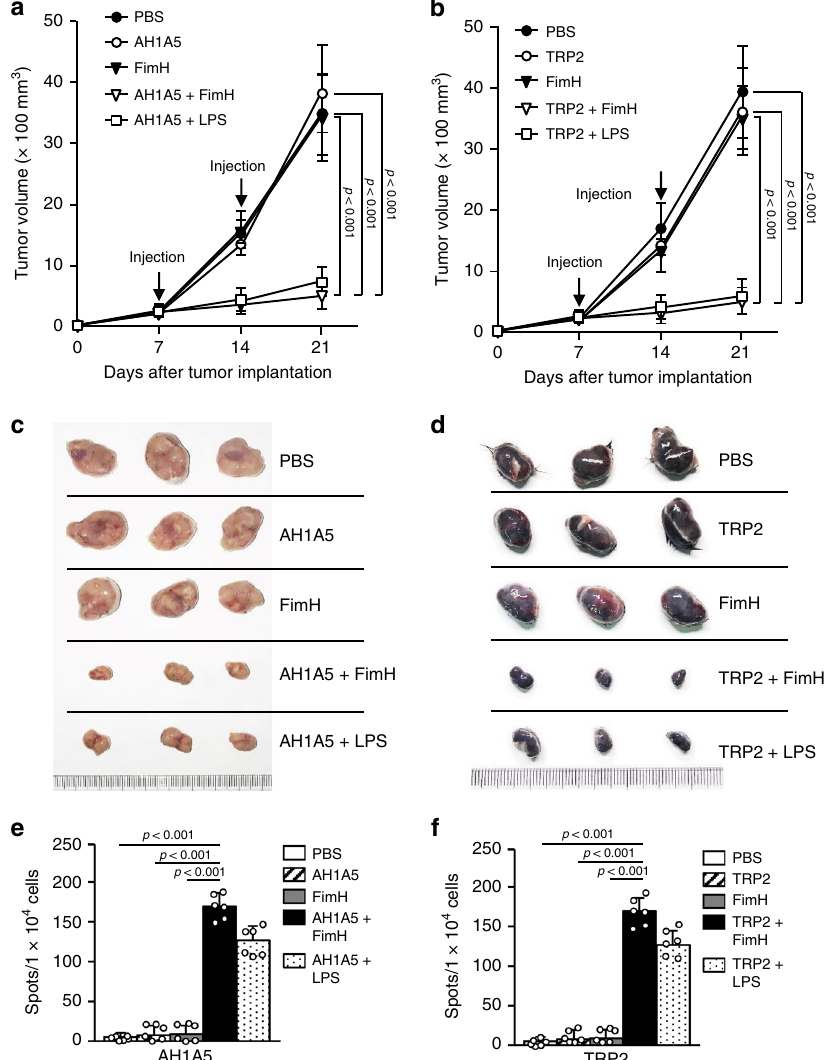
Fig. 5 FimH promotes cancer antigen (Ag)-speci fi c immune activation and anti-tumor immunity. BALB/c mice were injected s.c. with 1 × 10 6 CT26 carcinoma cells. After 7 and 14 days of tumor-cell injections, the mice were treated with PBS and 2.5 mg per kg of AH1A5, 2.5 mg per kg of FimH, or a combination of AH1A5 and FimH. The C57BL/6 mice were injected s.c. with 1 × 10 6 B16 melanoma cells. After 7 and 14 days of tumor-cell injections, the mice received PBS and 2.5 mg per kg of TRP2, 2.5 mg per kg of FimH, or a combination of TRP2 and FimH. a The growth curves of the CT26 tumors in the BALB/c mice and b the B16 tumors in the C57BL/6 mice are shown. ( n = 6 mice, signi fi cance determined by the log-rank test, mean ± SEM. c The CT26 carcinoma and d representative B16 melanoma tumor masses are shown. ( n = 6 mice). e AH1A5-speci fi c and f TRP2-speci fi c IFN- γ production in the tumor drLN of the BALB/c and C57BL/6 mice are demonstrated, respectively. ( n = 6 mice, one-way ANOVA, mean ±